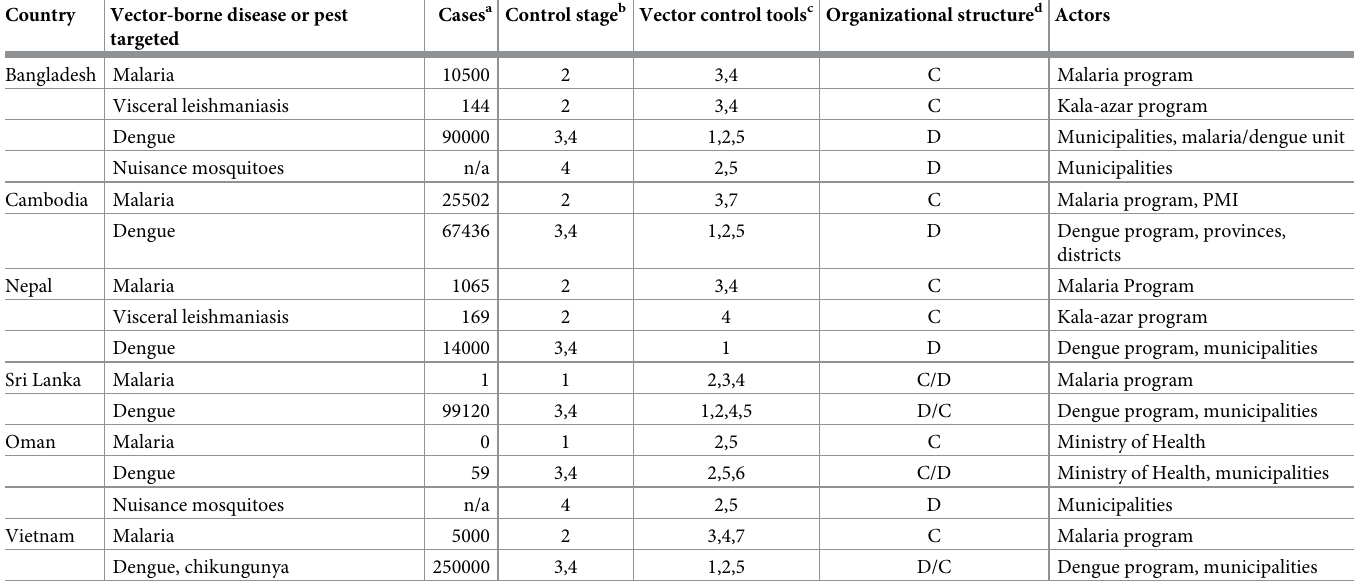
Table 1. The programs with vector control component in the selected countries. Country Vector-borne disease or pest